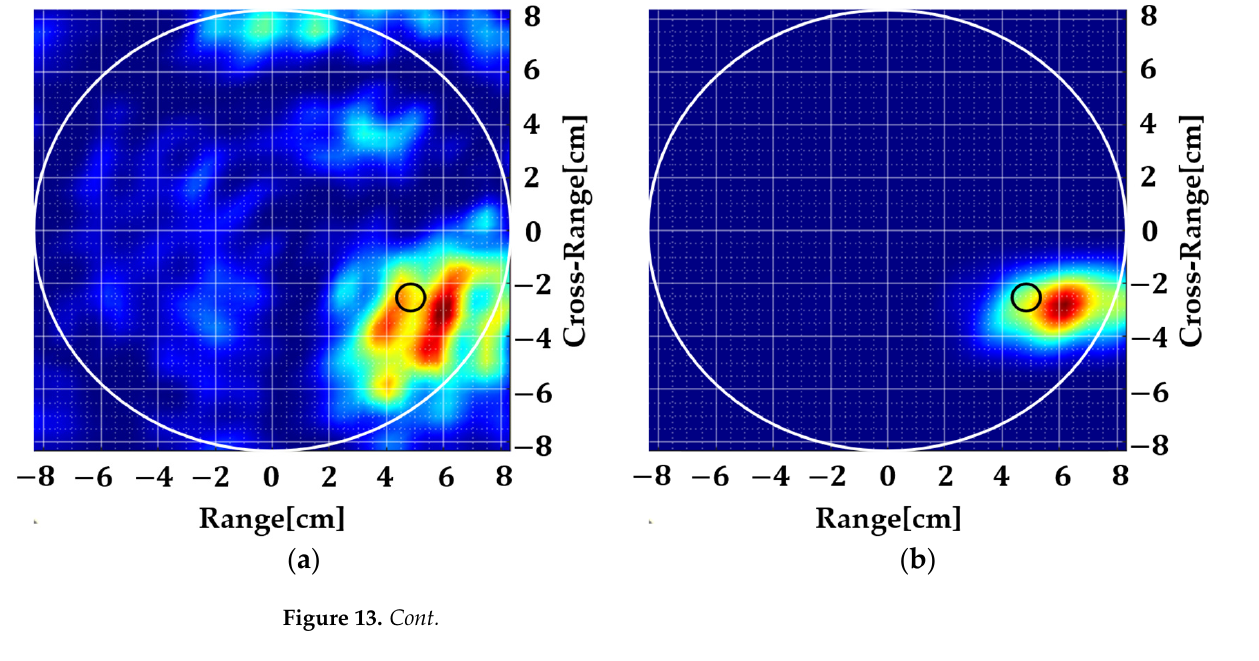
Figure 12. Measurement setup: ( a ) Side view where the antenna is mounted in a block of Styrofoam. ( b ) A plastic straw of 1 cm diameter filled with mineral water ( ε t = 80) is inserted in the background medium which constitutes wheat flour ( ε b = 2.5 ).